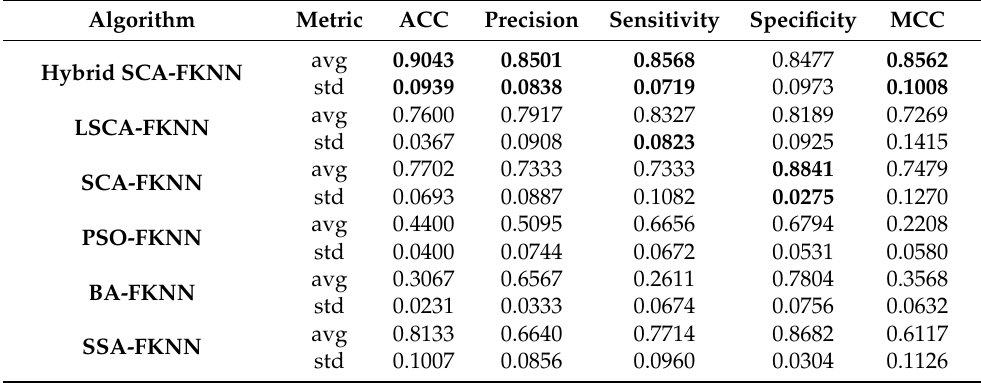
Table 14. Results of the hybrid-FKNN and comparison models on the QCM sensor alcohol dataset. (Bold indicates the best in comparison